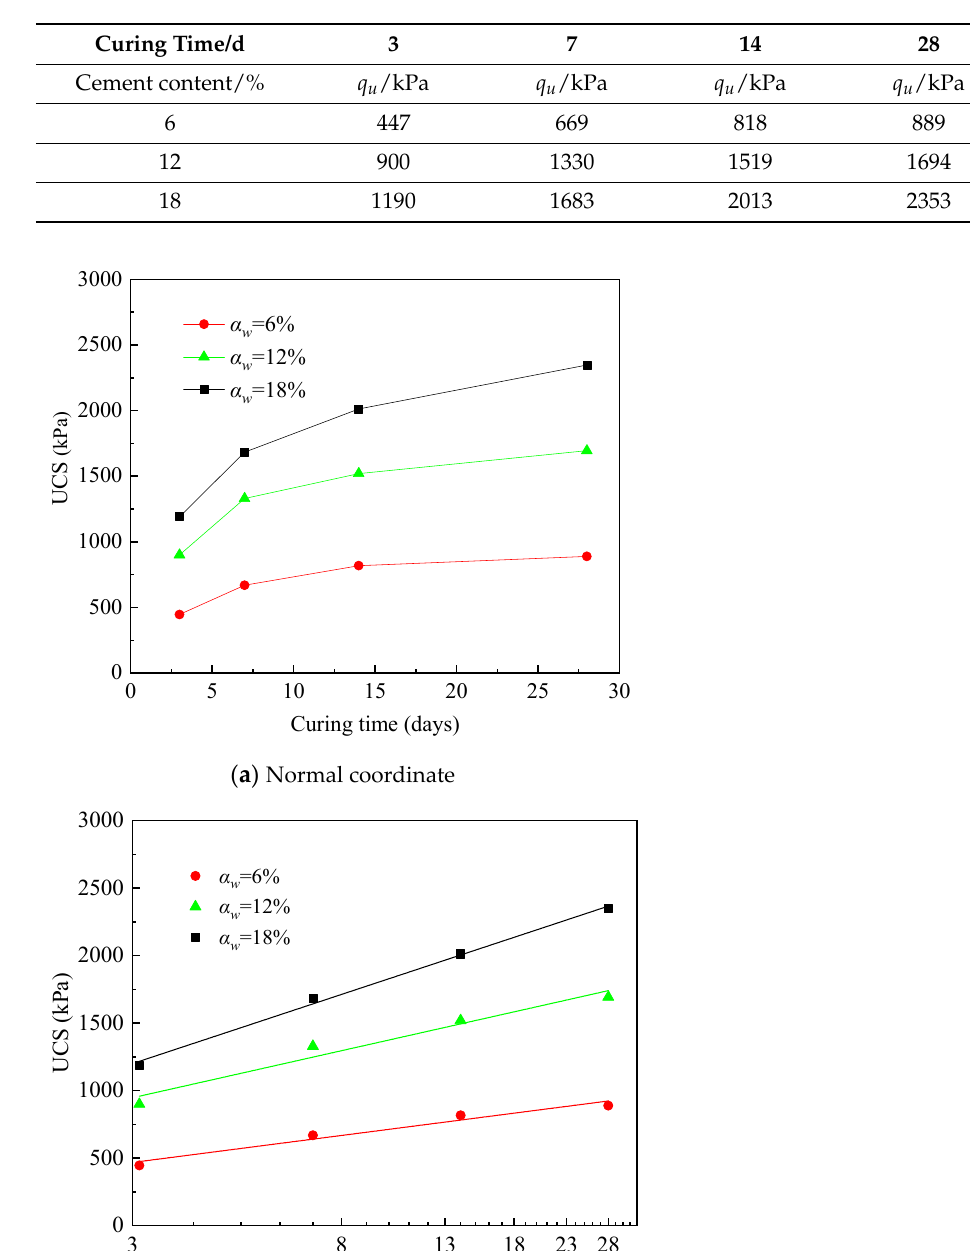
Table 3. The UCS test results.